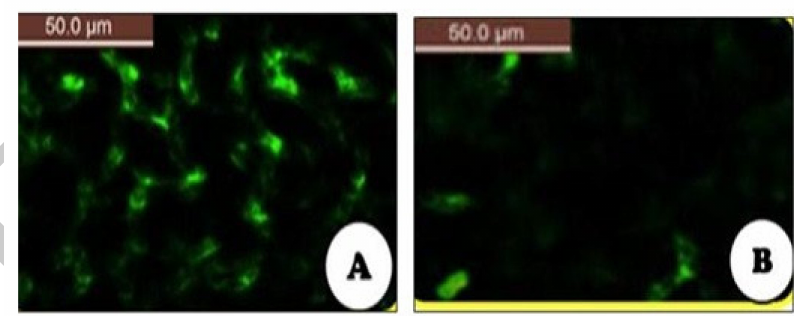
Figure 11. Mitochondrial membrane potential of the two groups: ( A ) diabetic group with a deep wound each (control group) and ( B ) diabetic group with a deep wound each that was treated with the C. molle